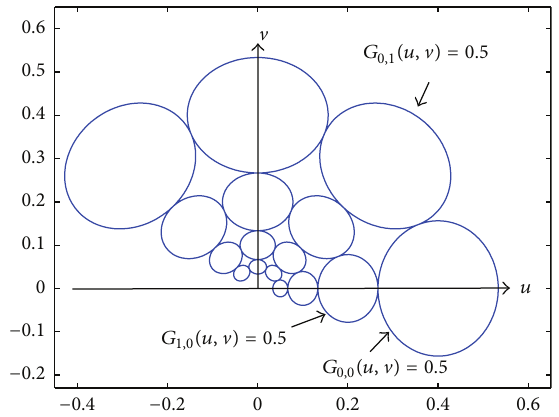
values of 𝛽 and 𝜂 are selected for each region. As can be observed, the classification accuracy is significantly higher than that of PCA, with an average correct classification rate of 96.46%.